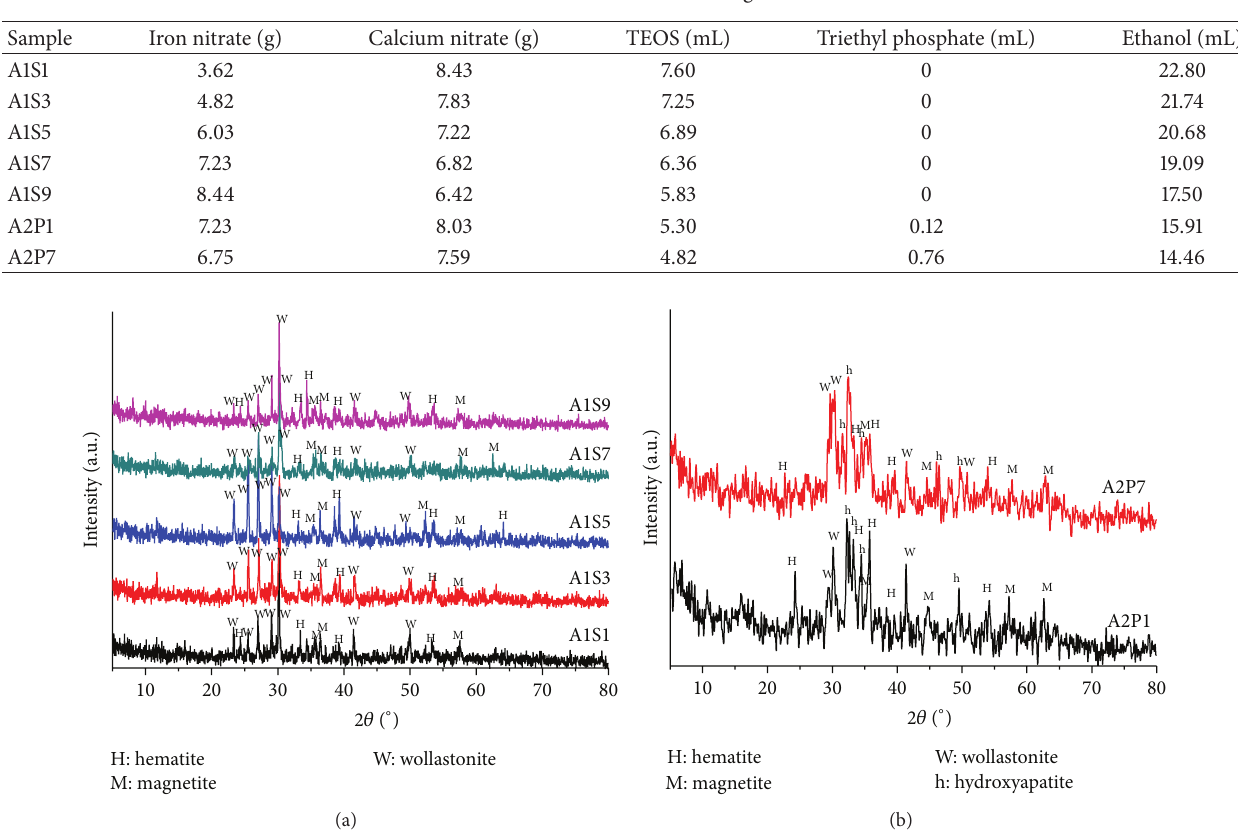
Table 2: The amount of the reagent.